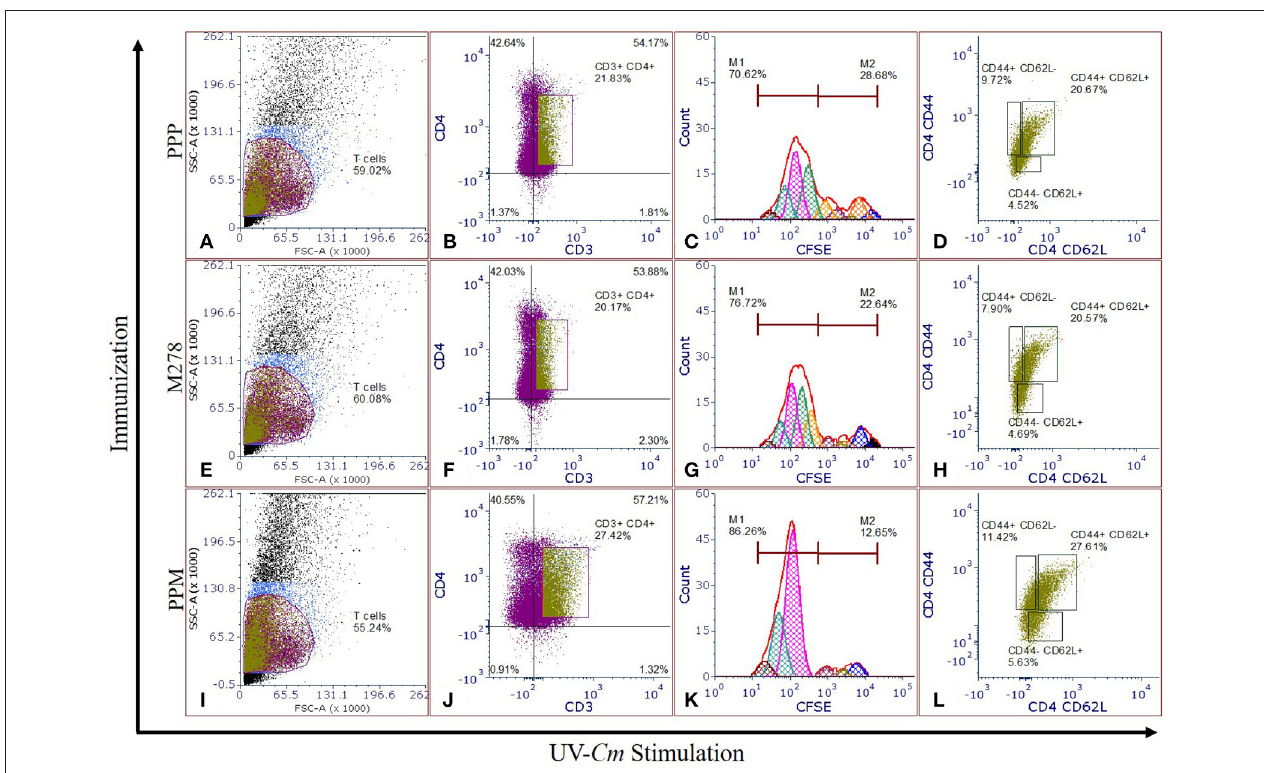
FIGURE 3 | Chlamydia -specific T-cells proliferation, and memory and effector T-cells phenotypes. CFSE labeled T-cells from PPP (A–D) , M278 (E–H), and PPM (I–L) immunized mice were co-cultured with naïve APCs, stimulated with 1 × 10 5 IFU of UV-Cm followed by incubation for 120h. Proliferating T-cells (CFSE + CD3 + ), and memory and effector phenotypes in proliferating T-cells populations were quantified by staining for CD3, CD4, CD44, and CD62L. Histograms (C,G,K) of CFSE fluorescence intensity to quantify CFSE + CD3 + CD4 + proliferating (M1) and resting (M2) T-cells, and dot plots showing the expression of CD44 and CD62L (D,H,L) were derived by gating on CFSE + CD3 + CD4 + stimulated T-cells (B,F,J) from PPP (A–D) , M278 (E–H), and PPM (I–L) immunized mice. PPP (PLA-PEG-PBS immunized group); M278 (bare M278 immunized group); PPM (PLA-PEG-M278 immunized group); UV-Cm (UV-inactivated